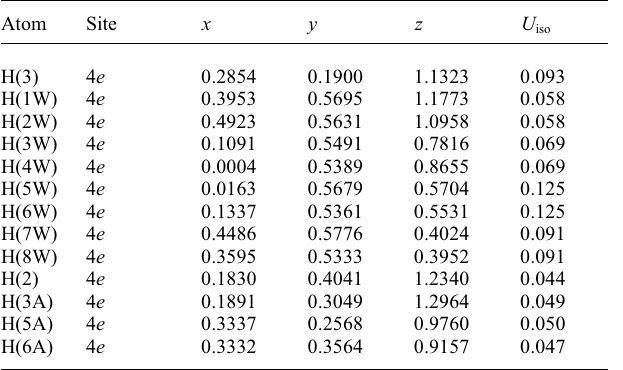
Table 3. Atomic coordinates and displacement parameters (in Å 2 ) .